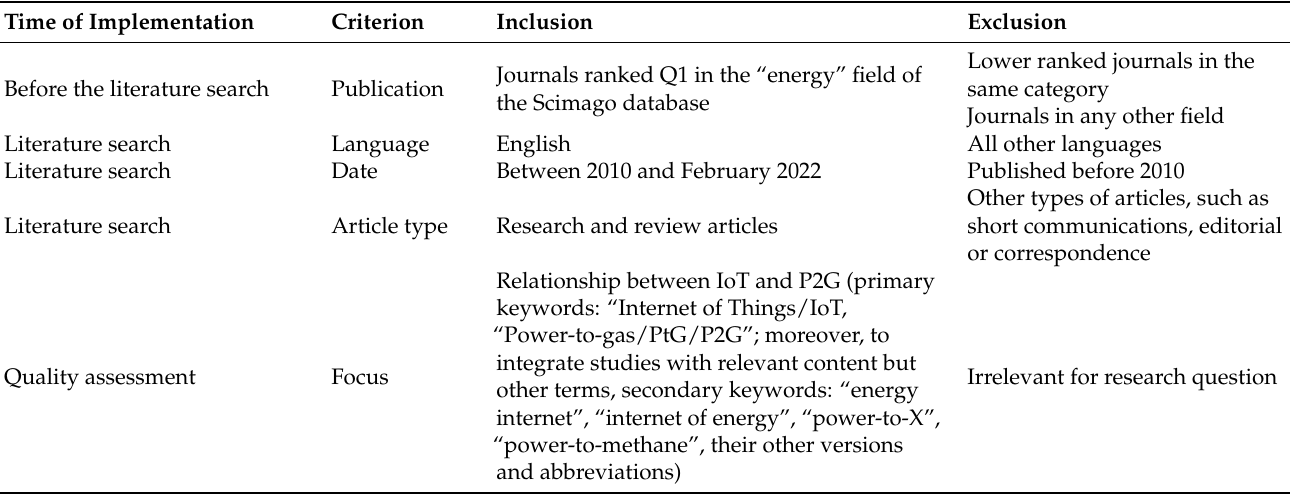
Table 1. Inclusion and exclusion criteria (own construction).